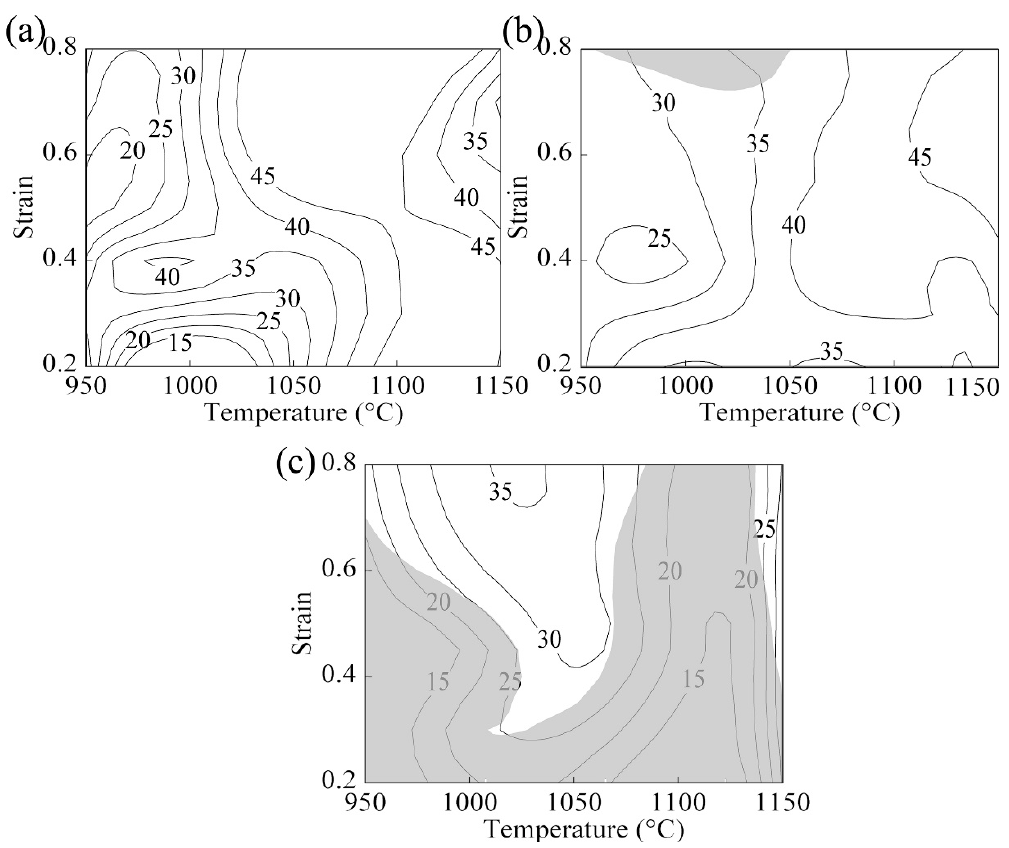
Figure 9. Processing maps of GH4698 at the strain rates of ( a ) 0.001 s − 1 , ( b ) 0.1 s − 1 , and ( c ) 3 s − 1.